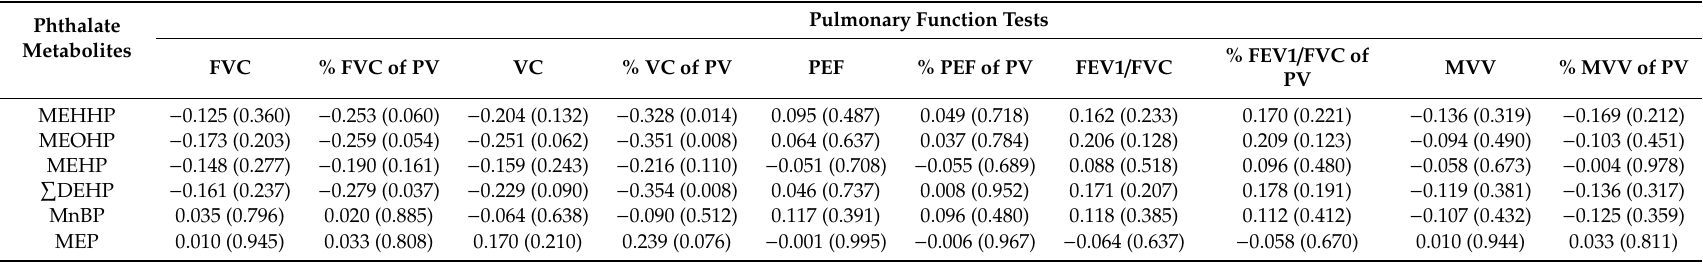
Table 7. Bivariate analysis between PFT parameters and phthalate metabolites in females (n = 66), Spearman correlation coe ffi cient ( p value).